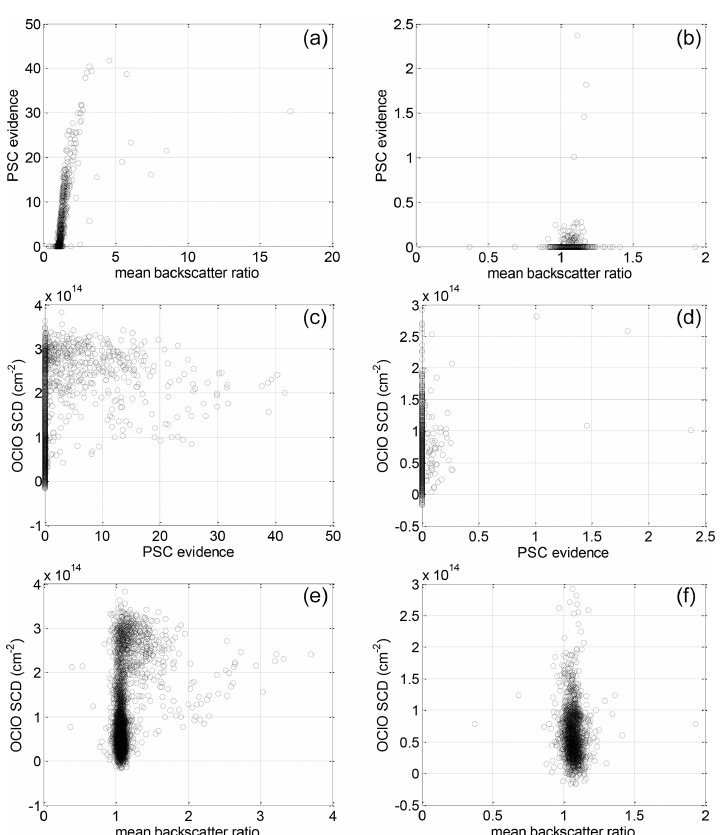
Figure B2. (a, b) Correlation plots between PSC evidence and the mean backscatter ratio. (c, d) Correlation plots between the OClO SCDs and the PSC evidence. (e, f) Correlation plots between the OClO SCDs and the mean backscatter ratio. In panels (a, c, e) , data for May–July 2020 are considered, and in panels (b, d, f) , just data for May 2020 are included.